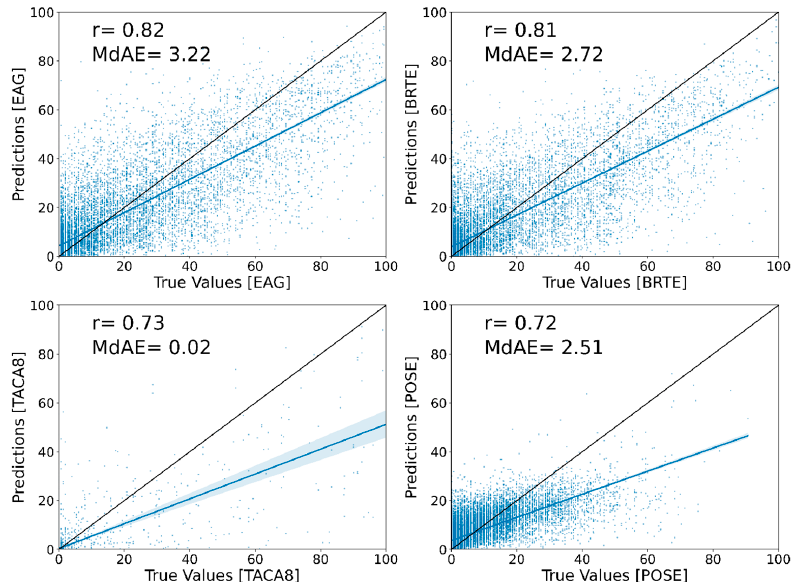
Figure 4. Scatterplots showing agreement between modelled and independent test samples for EAGs and each individual species. On the TACA8 scatterplot, the blue line and the shaded zone around it represent the regression line and the 95th percent confidence interval for the regression. The 95th percent confidence intervals are too small on the three other scatterplots to be visible. The black line represents the 1:1 relation. EAG represents a combination of 16 exotic annual grasses, BRTE is cheatgrass, TACA8 is medusahead, POSE is Sandberg bluegrass, r equals the correlation coefficient, and MdAE equals the median absolute error.